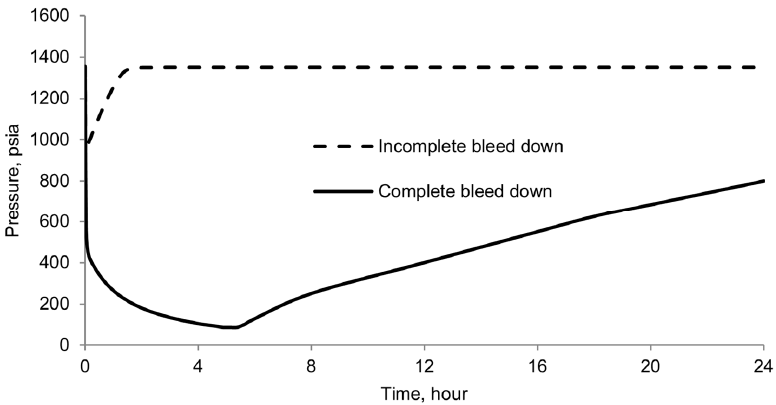
Figure 12. Minimum bleed down pressure can be achieved by leaving the valve open more; maximum build up pressure can be found by closing the valve earlier.